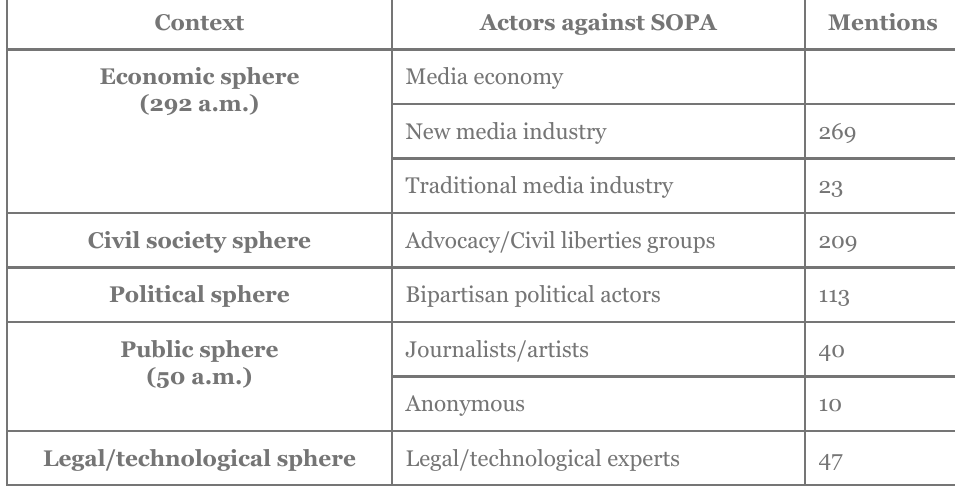
Table 3: Mentions by actors opposed to